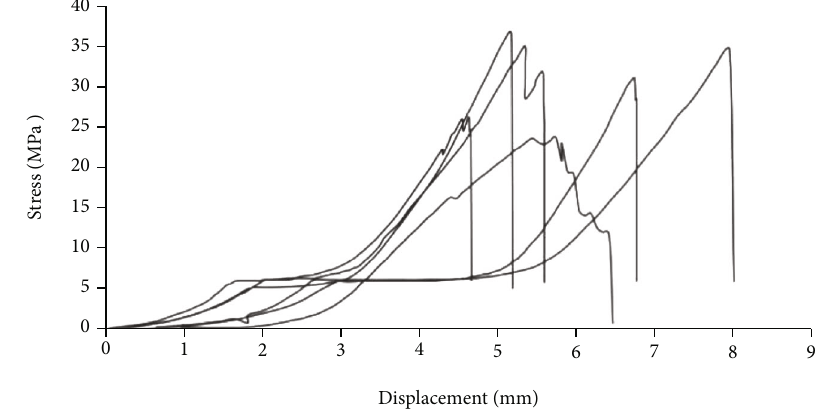
Figure 7: Stress-strain curves of testing sample.